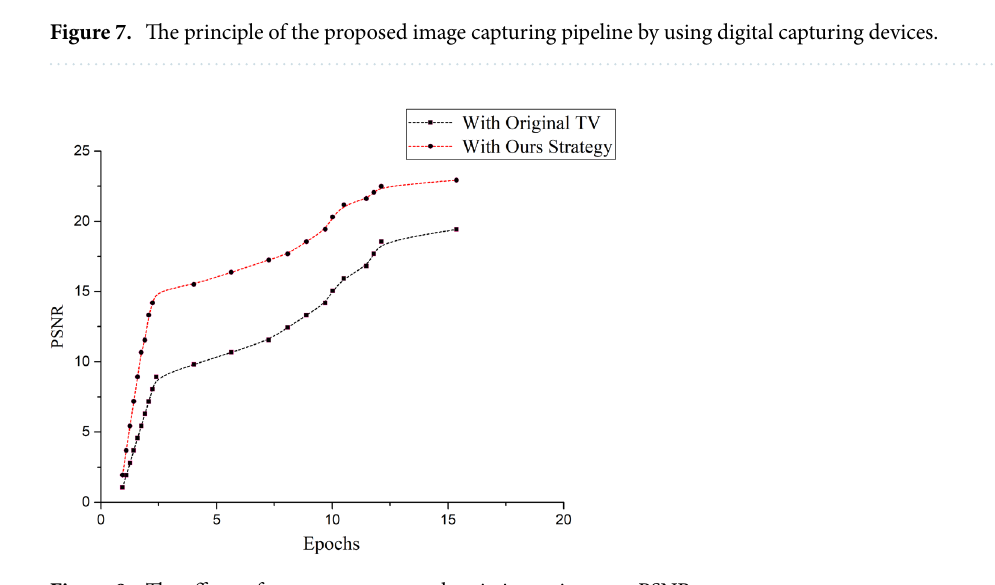
Figure 8. The effects of our strategy on total variation to improve